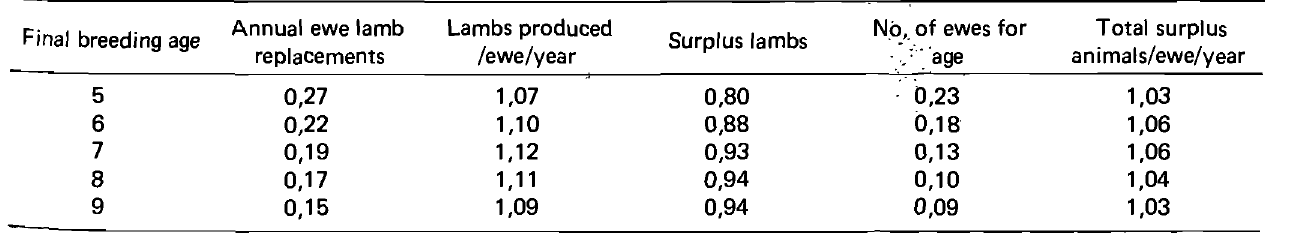
Tabre 5: THE INFLUENCE OF FINAL BREEDING AGE ON THE TOTAL NUMBER OF SURPLUS ANIMALS PRODUCED